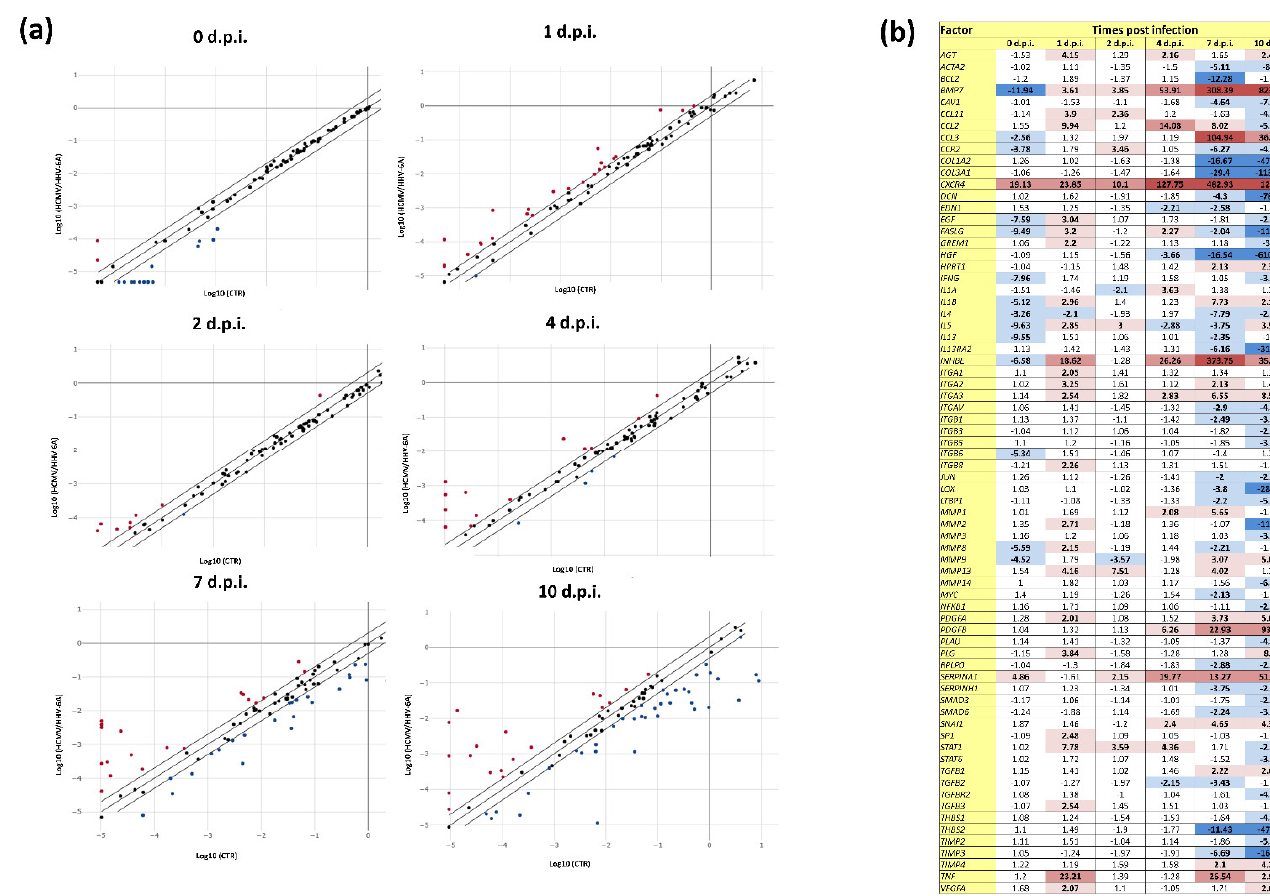
Figure 2. Expression of fibrosis-associated factors in response to HCMV/HHV-6A coinfection of human dermal fibroblasts. Cell samples were collected at the indicated days post infection (d.p.i.) and analyzed by qPCR microarray. ( a ) Scatterplot representation: the threshold was 2-fold change in infected vs. control cells; red and blue dots represent up-regulated and down-regulated factors, respectively; results are expressed as mean values of duplicate samples in two independent experi- ments. ( b ) Detailed values of down- and up-regulated factors: dark blue, down-regulation >10-fold; light blue, down-regulation between 2- and 9.9-fold; light red, up-regulation between 2- and 9.9-fold; red, up-regulation between 10- and 99.9-fold; dark red, up-regulation >100-fold. All values above the 2-fold threshold are indicated in bold.